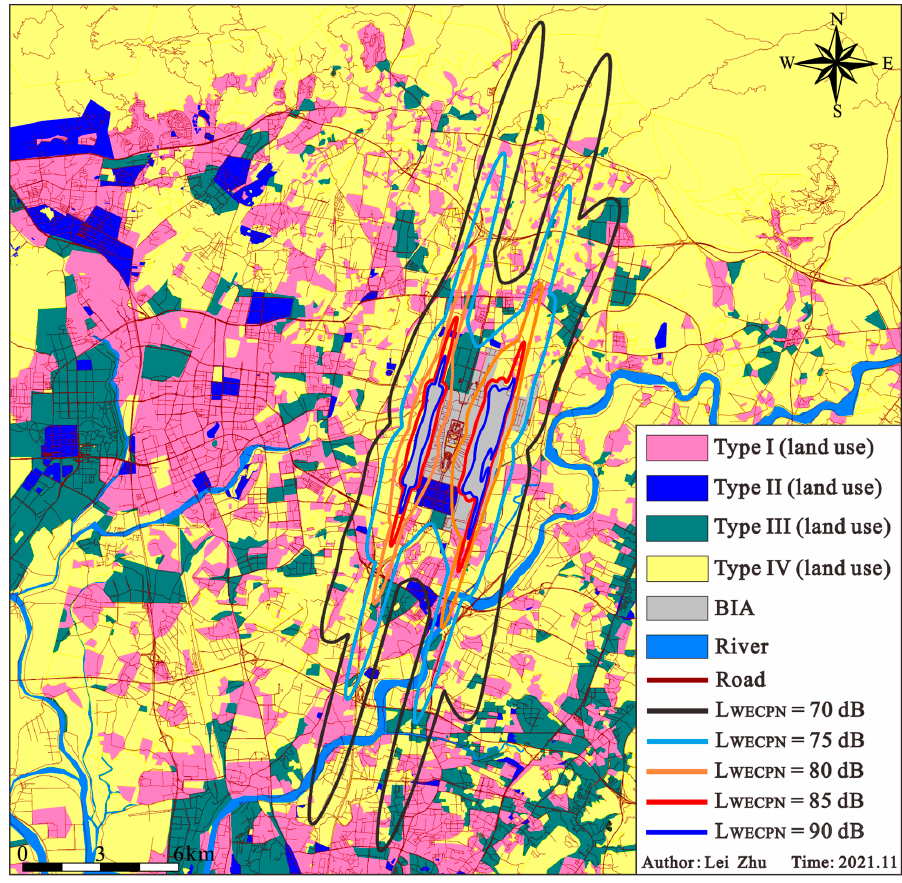
Figure 13. Land use map around BIA. Table 6. Land use planning under different noise levels ( L WECPN ) around BIA. “Existing” indicates the existing buildings, “new” indicates the new buildings.